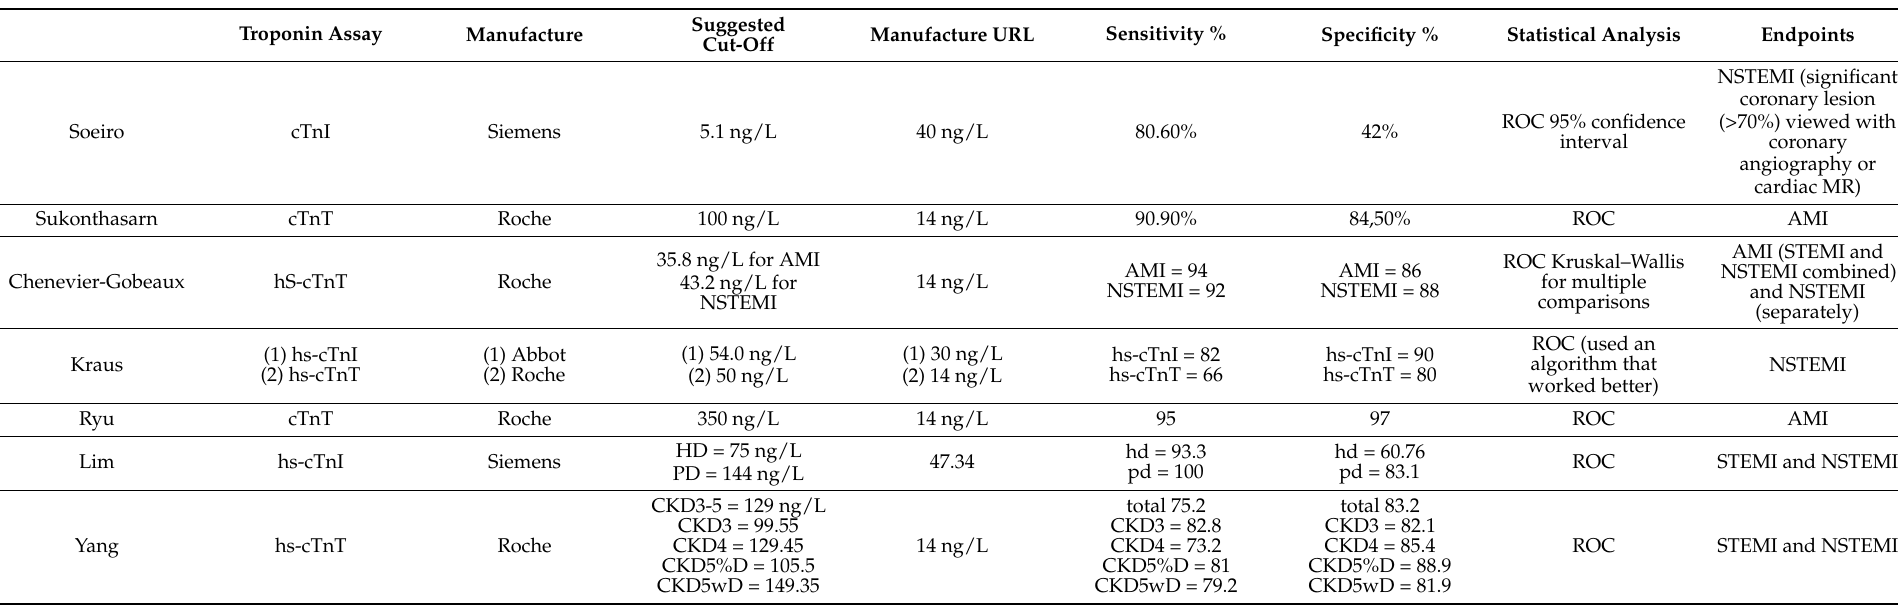
Table 2. Troponin cut-off details for the included studies for the systematic review of cut-off values for troponin in patients with chronic kidney